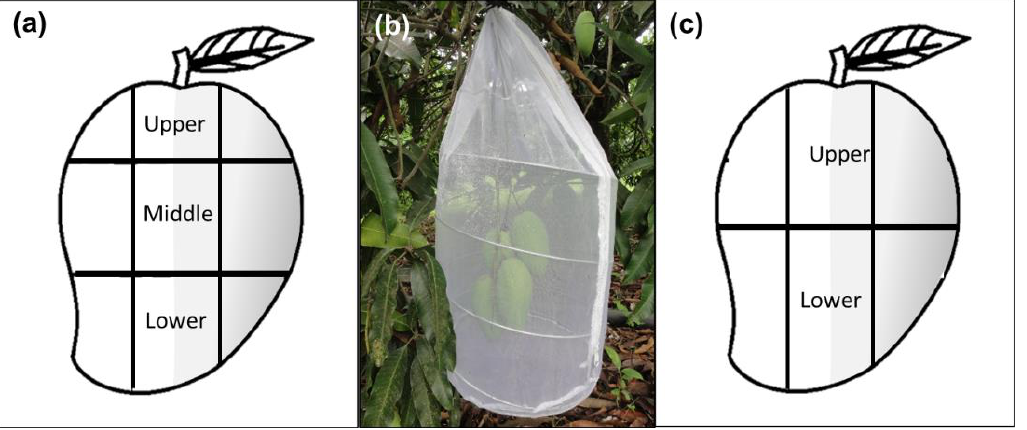
Figure 1. Sampling approaches and branch-bagging scheme followed depicting sections (upper, middle and/or lower) and shaded (gray color) or sunny areas used in the experiments under semi- natural field conditions: ( a ) Sampling design used in the studies of oviposition behavior, infestation, determination of total phenolic compounds, proteins, carbohydrates, and lipids in Studies 1 and 2; ( b ) Branches with marked mango fruit bagged with an organza cage for observations on female’s oviposition activity; ( c ) Sampling design used for the targeted and untargeted metabolomic analysis of fruit phenolic compounds in Studies 3 and 4.